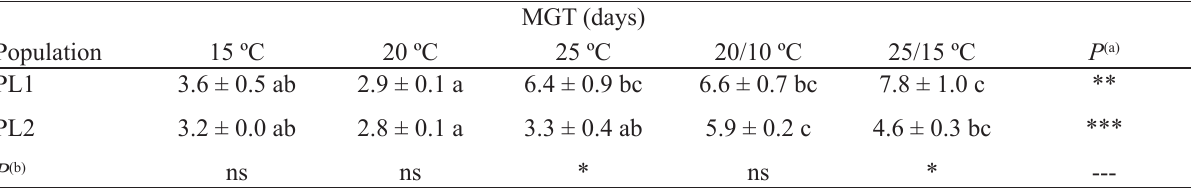
Table 3. Mean germination time (MGT, mean ± SE) at different temperature regimes for two populations of Plantago lanceolata . Mean values within a row followed by the same letters are not significantly different. Abbreviations are: P (a) : For each population, significance level among the MGT values from temperatures; P (b) : For each temperature, significance level among MGT values from populations; *** P < 0.001; ** P < 0.01; * P < 0.05; ns, not significant.